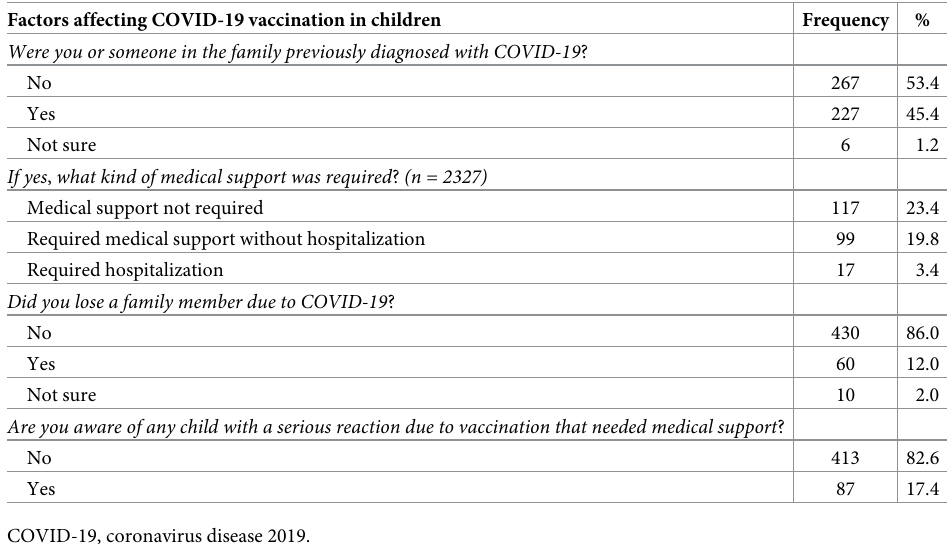
Table 3. History of COVID-19 in participants ( n = 500). Factors affecting COVID-19 vaccination in children Frequency % Were you or someone in the family previously diagnosed with COVID-19